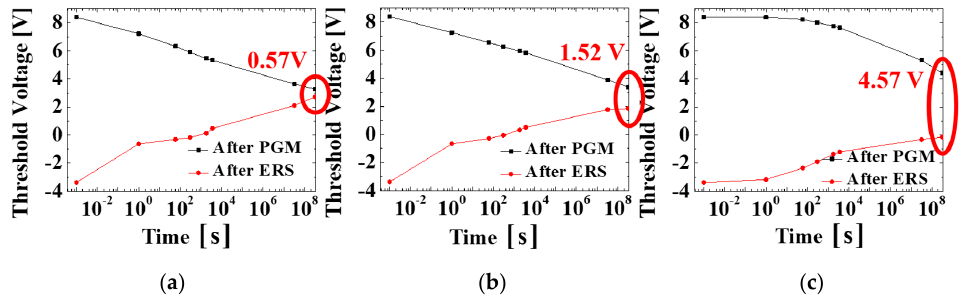
Figure 7. Detailed description of retention characteristics in ( a ) conventional TAHOS, ( b ) BE- TAHOS, and ( c ) proposed TAHOAOS structure. and ( c ) proposed TAHOAOS